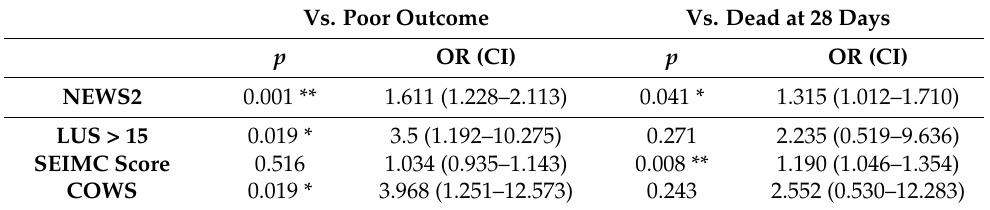
Table 1. Differences between favourable and poor outcome and between alive and dead